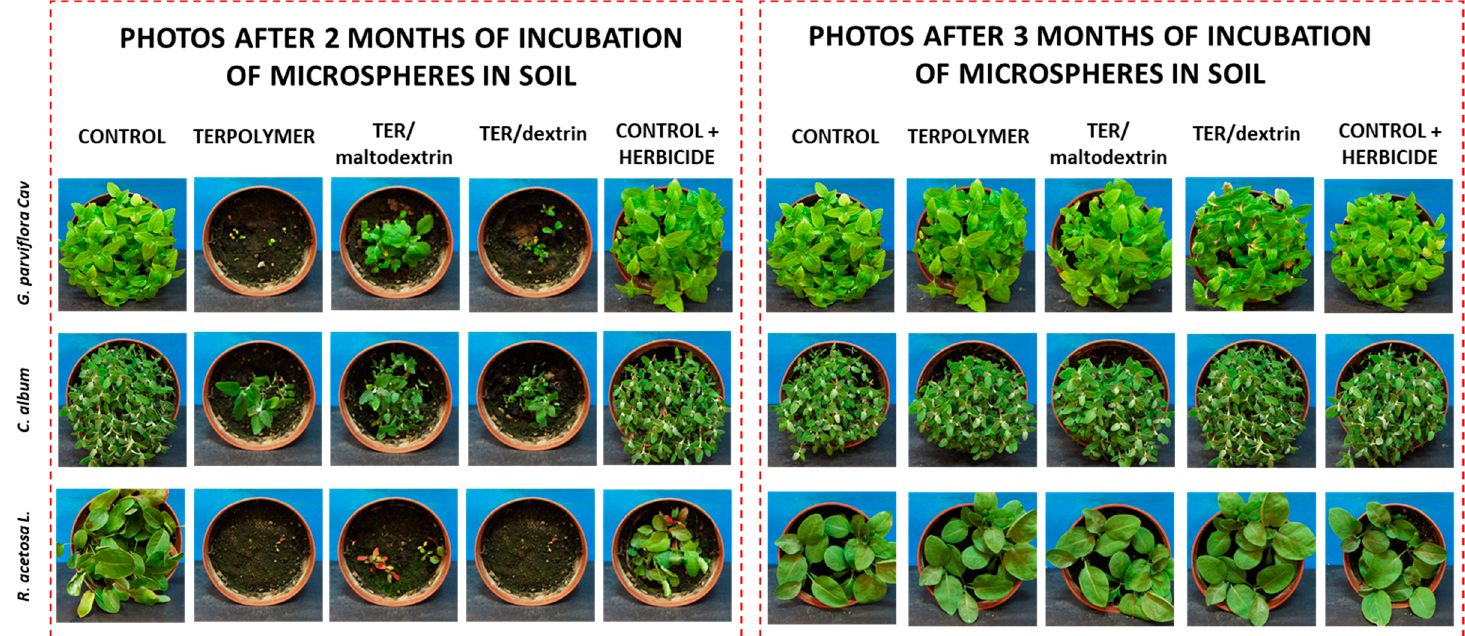
Figure 11. Herbicidal activity assessment of released pendimethalin loaded into microspheres in double recommended dose. Seeds of each plant were sown after two and three months of incubation of microspheres in soil. Table 5. Herbicidal activity assessment of released pendimethalin loaded into microspheres in double recommended dose (EWRC scale). 2 Months after Incubation of Microspheres in Soil 3 Months after Incubation of Microspheres in